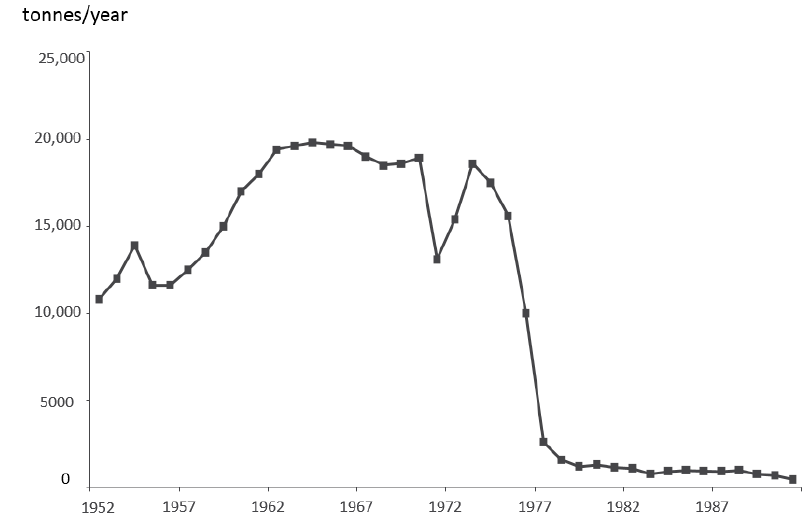
Figure 1. Imports of raw asbestos to Sweden, 1952–1991.